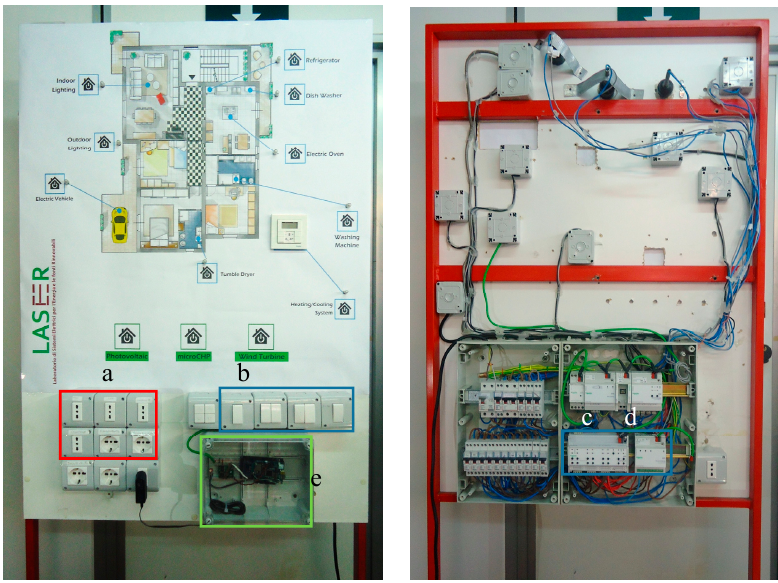
Figure 11. Front and rear side of the demonstration panel mounted with a real home automation.